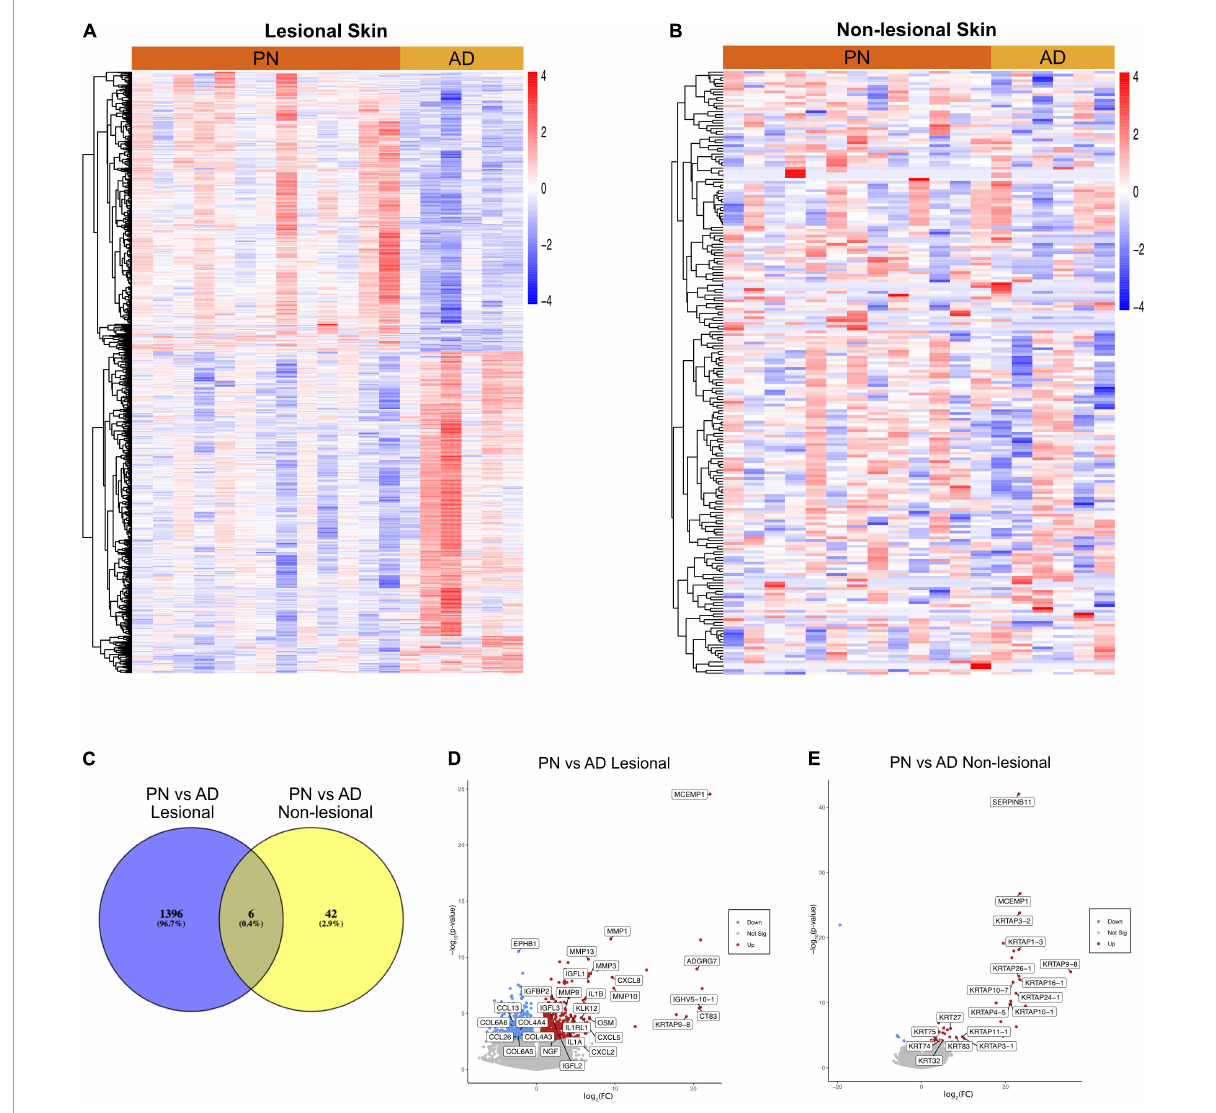
FIGURE2 Transcriptomic comparisons of prurigo nodularis (PN) and atopic dermatitis (AD) skin. (A) Heatmap of gene expression for differentially expressed genes (DEGs) between PN lesional vs. AD lesional samples, where red is higher expression and blue is lower expression. (B) Heatmap of gene expression for differentially expressed genes (DEGs) between PN non-lesional vs. AD non-lesional samples, where red is higher expression and blue is lower expression. (C) Venn diagram of DEGs for PN lesional and AD lesional samples compared to PN non-lesional and AD non-lesional samples. (D) PN lesional vs. AD lesional volcano plot. (E) PN non-lesional vs. AD non-lesional volcano